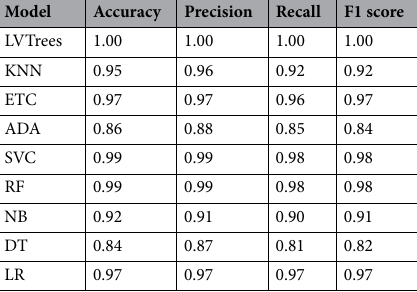
Table 14. Performance of models after applying both CHI2 and ADASYN techniques.